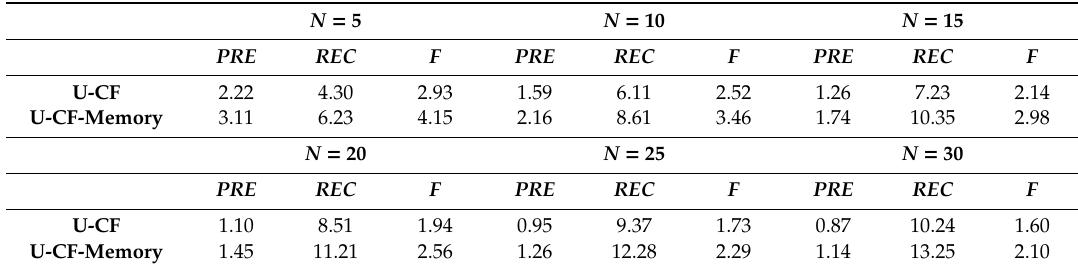
Figure 6. Comparison of recommendation performance. ( A ) Precision of the top N recommendations. ( B ) Recall among the top N recommendations. ( C ) F-value of the top N recommendations. Table 3. Comparison of recommendation